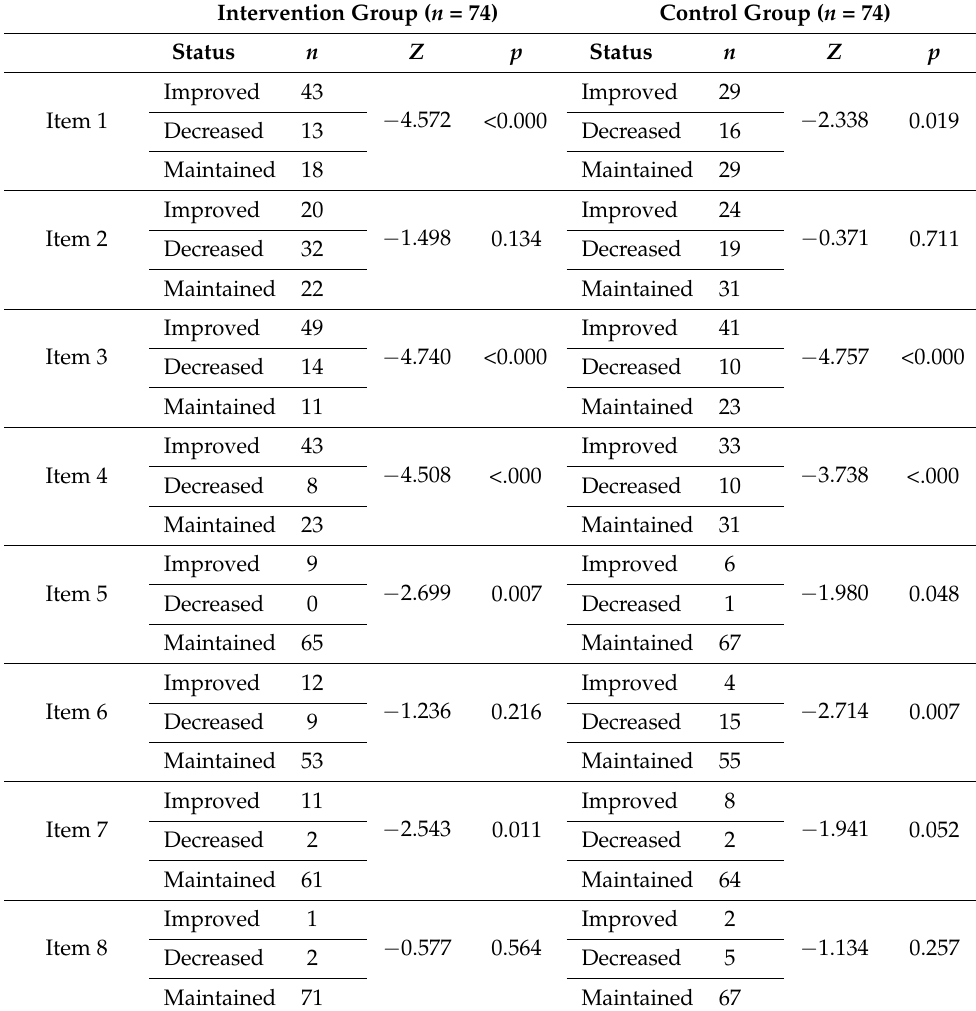
Table 4. Within groups comparison with Wilcoxon signed-rank test for each item of the Adapted Fresno Test—ITT